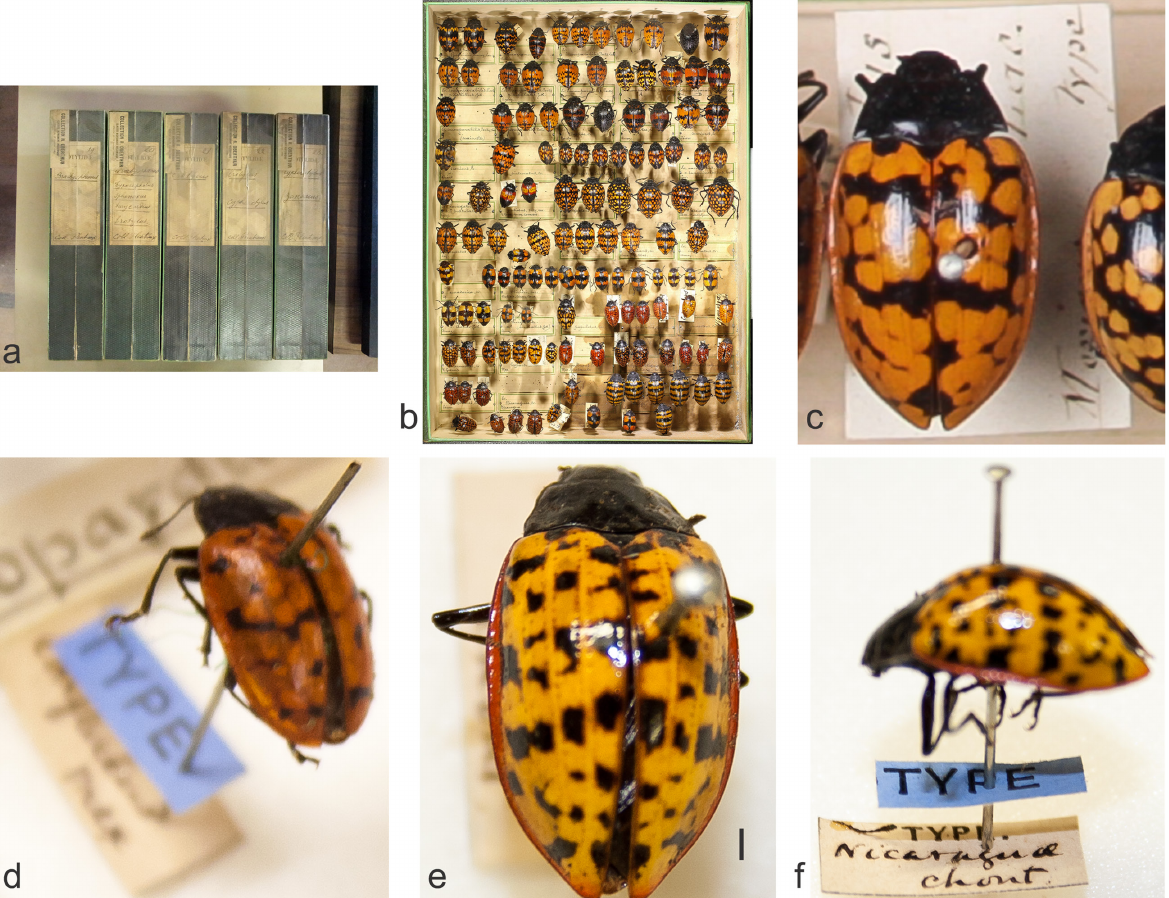
Figure 1. Type material examined. a–b. Drawers from Oberthür collection (MNHN). c. Lectotype of Erotylus leopardus Lacordaire, 1842 (MNHN). d. Lectotype of Erotylus confluens Crotch, 1876 (UMZC). e–f. Lectotype of Erotylus nicaraguae Crotch, 1876 (UMZC). Scale bars: e = 1